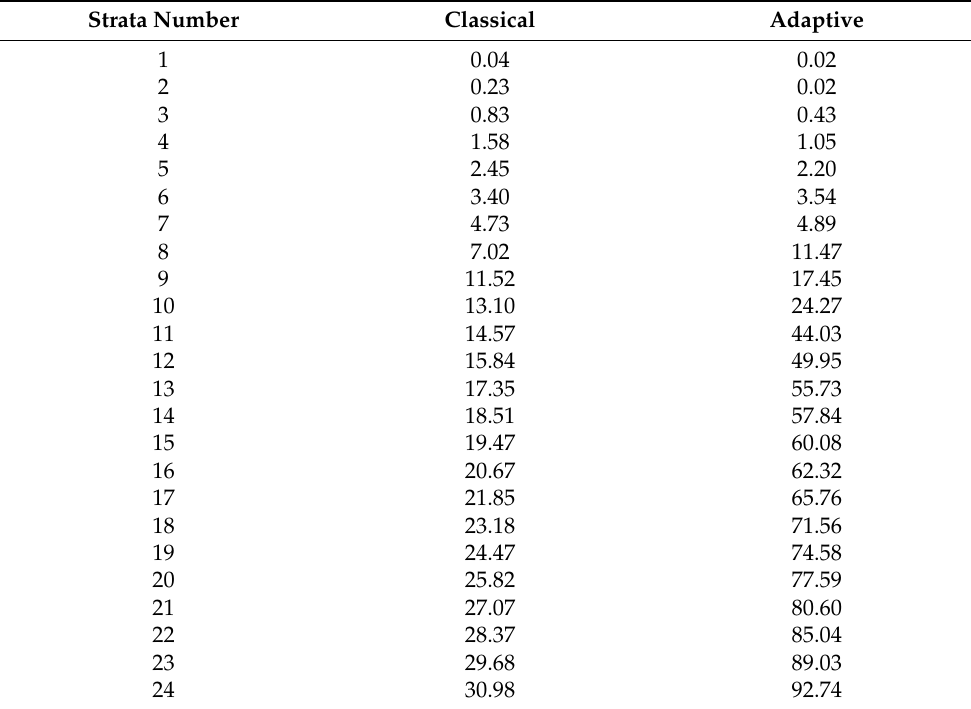
Table 2. The efficiency-error ratio of different interpolation methods and stratum numbers. Strata Number